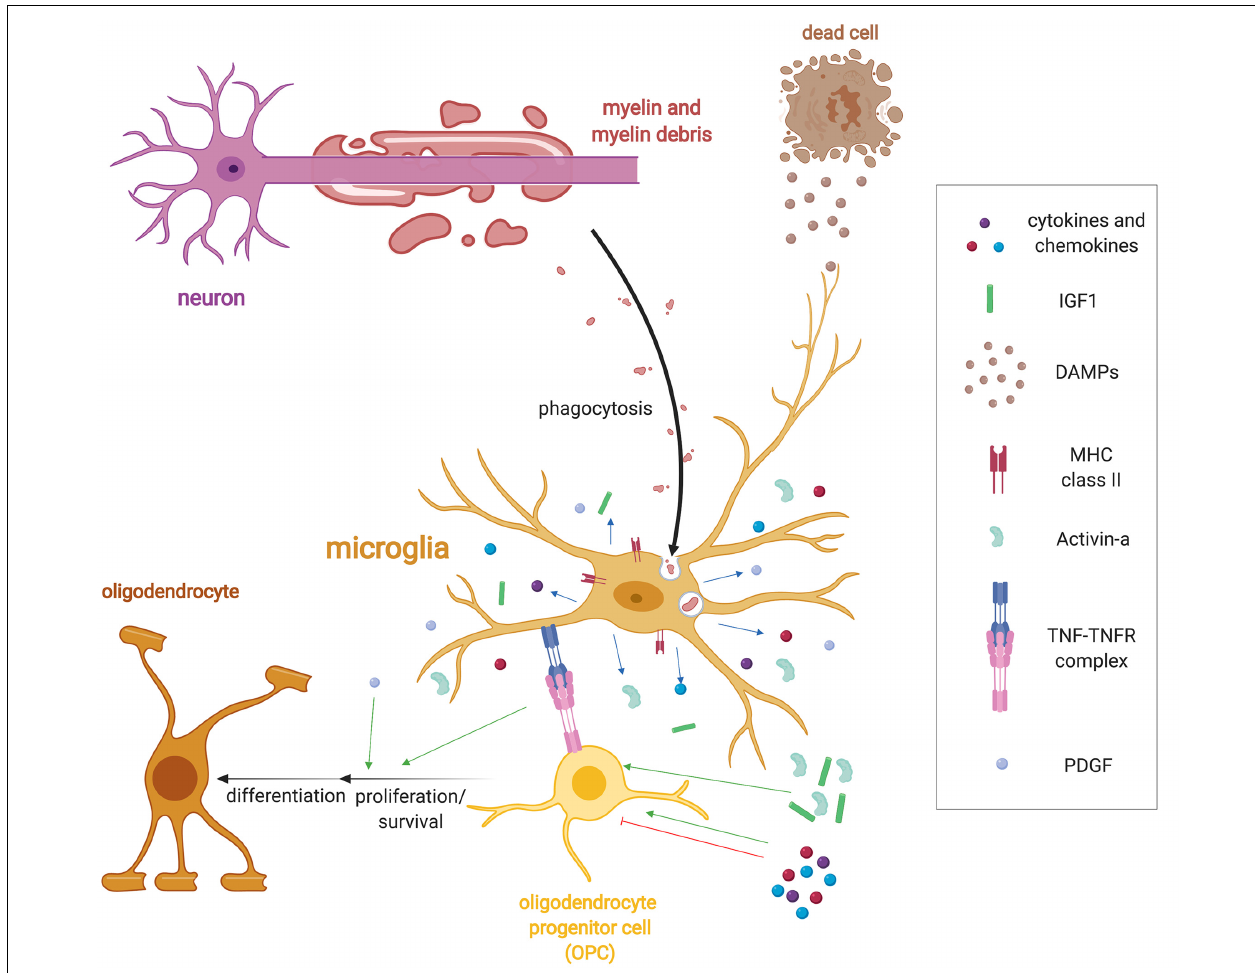
FIGURE 1 | Microglia regulation of remyelination. Following demyelination, microglia detect injury in the form of damage associated molecular patterns (DAMPs) via a variety of receptor classes such as pattern recognition receptors, purinergic and fractalkine receptors, and cytokine receptors. DAMPS induce a wide range of functions including the activation of microglia to phagocytose myelin and cellular debris. Microglia also upregulate a host of immune molecules when activated such as MHC-II expression and release cytokines, chemokines and growth factors such as Activin-A, platelet-derived growth factor (PDGF), IL-1 β , and IGF-1 that regulate oligodendrocyte progenitor cell (OPC) lineage progression. They also express tumor necrosis factor- α (TNF- α ), which binds to TNF receptor 2 (TNFR2) to promote